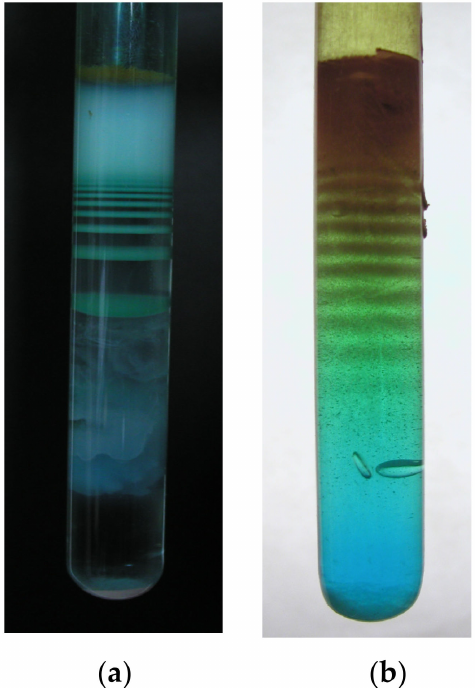
Figure 1. Examples of ‘Liesegang rings’: ( a ) Rings composed of Na 2 Cu(OH) 4 colloid precipitate; ( b ) Rings composed of fine metallic Cu crystals. The diameter of the test tube is 1 cm in both frames. For other details regarding the experimental setup, the reader is referred to Table